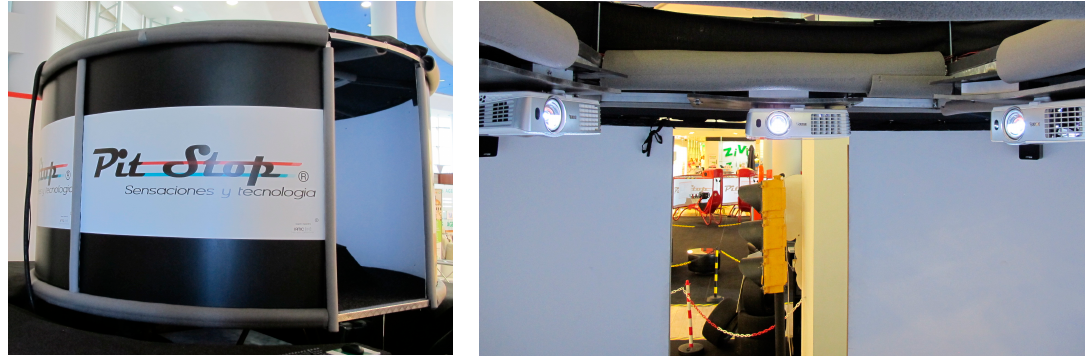
Figure 1. View of the exterior of the F1 simulator ( left ) and the projectors of the inside ( right ).